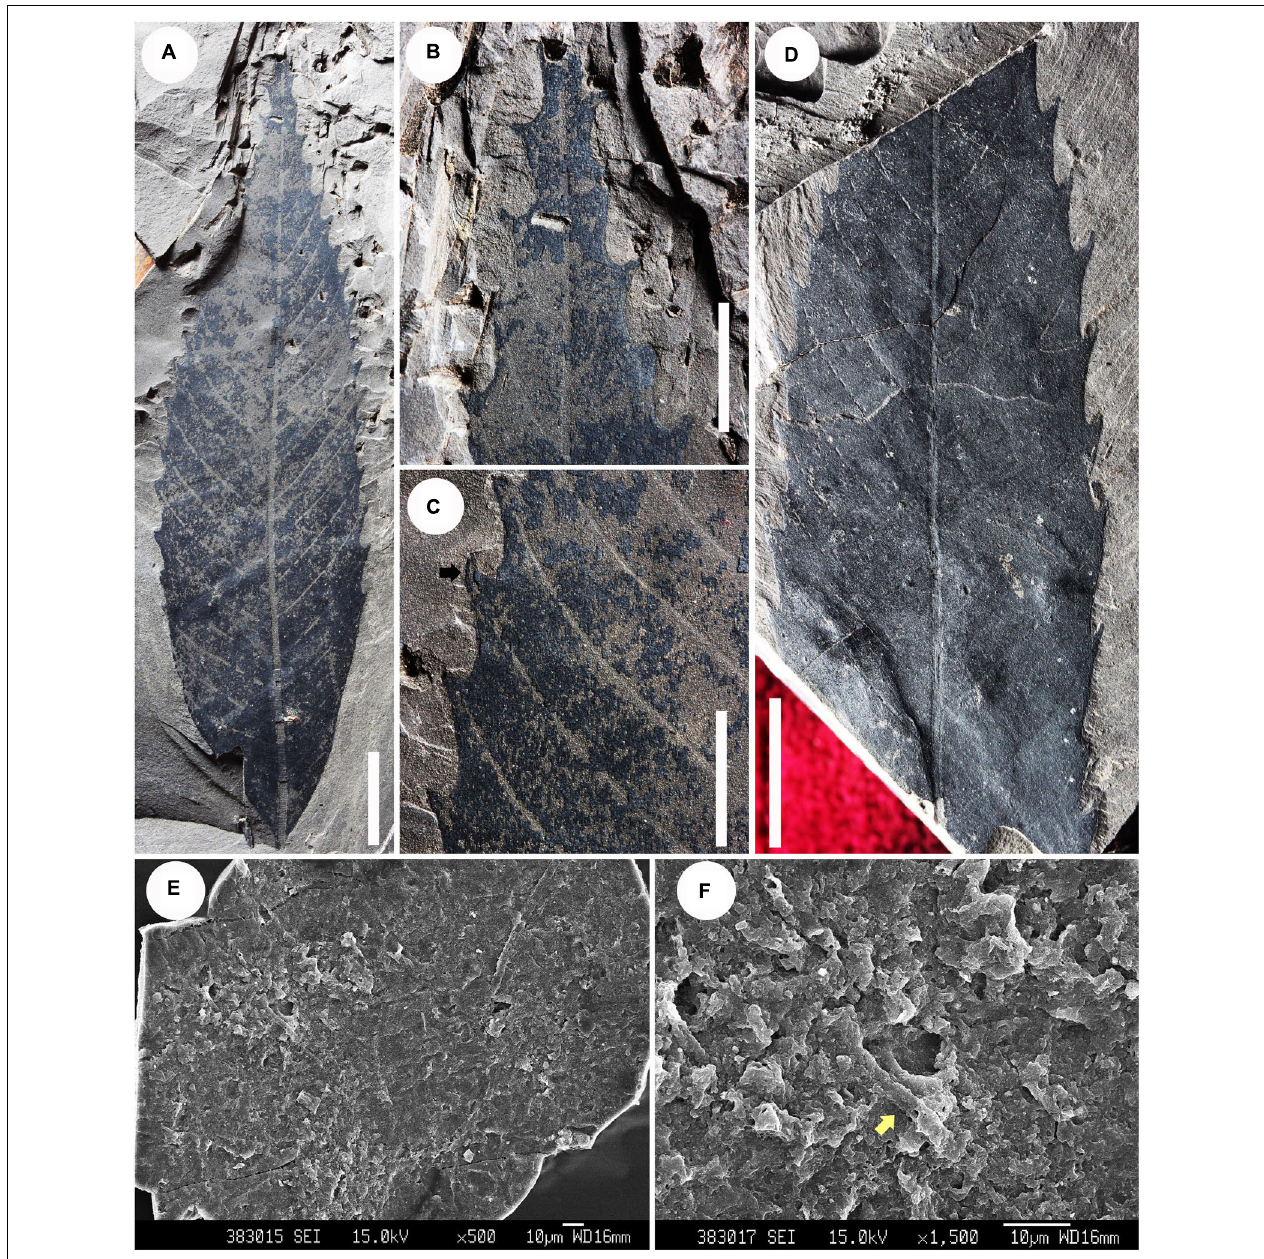
FIGURE 11 | Morphology of Quercus paleolamellosa sp. nov. (A) Holotype. Specimen No. CC-1112a, showing the lanceolate leaf and plenty of veins; (B) enlargement of (A) , showing the acuminate apex with teeth; (C) enlargement of (A) , showing the teeth (black arrow); (D) paratype. Specimen No. CC-1261, showing the teeth and venation. (E) SEM image of (D) , showing the rugose outer surface and solitary trichomes; (F) enlargement of (E) , showing the details of the solitary trichomes (yellow arrow). Scale: 10 mm (A,D) ; 5 mm (B,C)